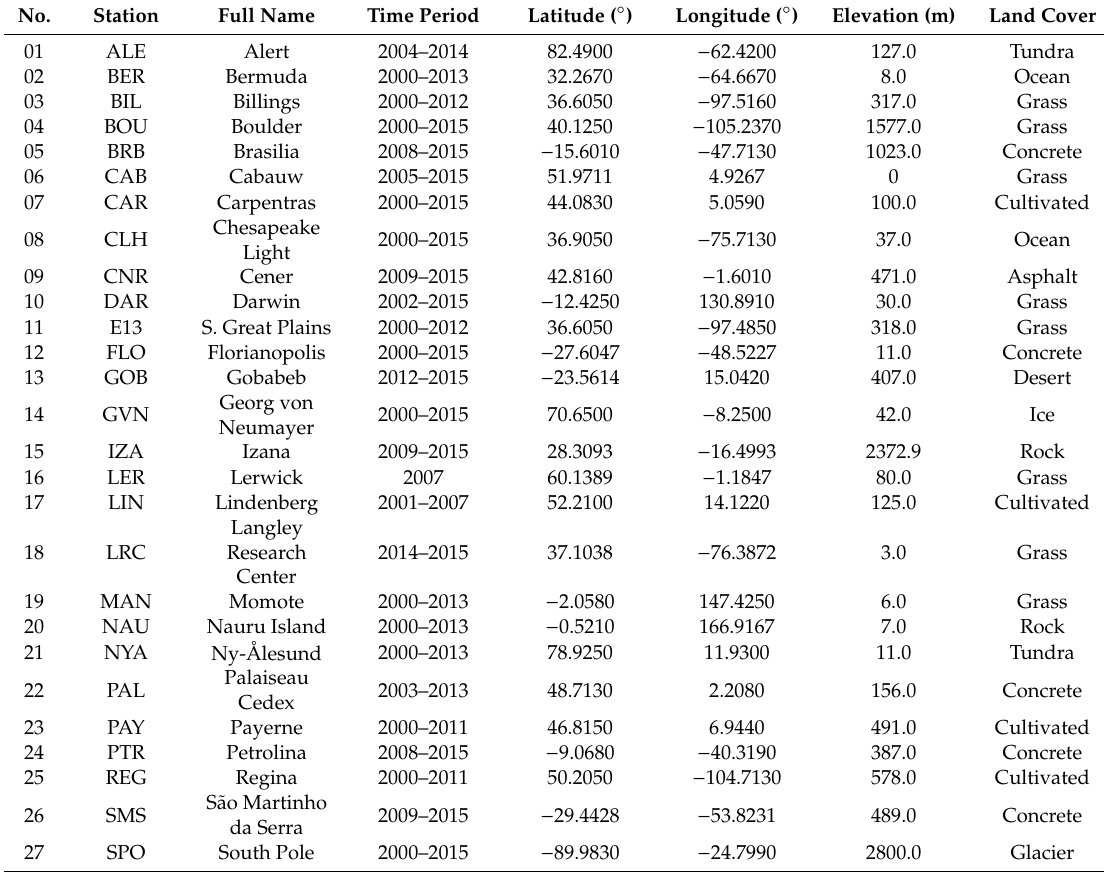
Table 1. Detailed information of 27 BSRN